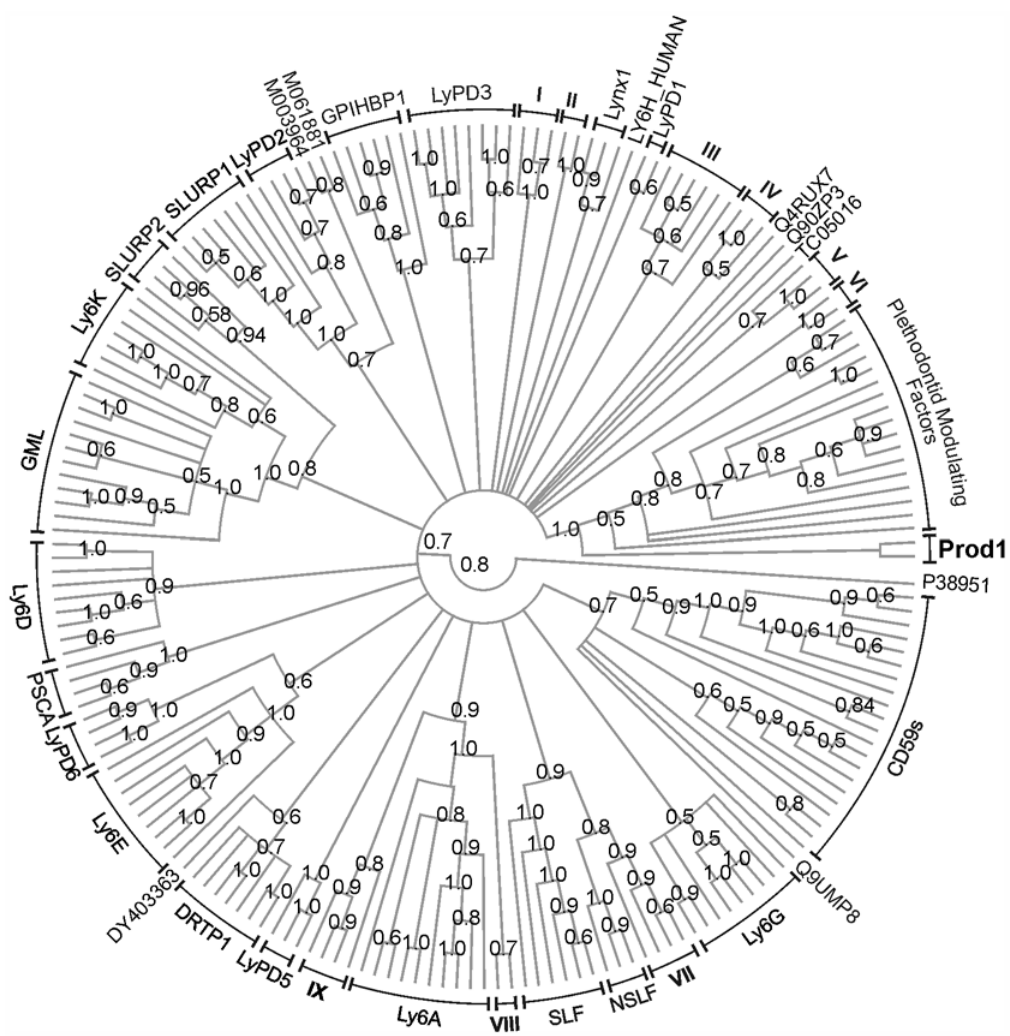
Figure 5. Majority-rule consensus phylogenetic tree of representative sequences of single-domain TFPs computed by Bayesian inference using MrBayes. Numbers indicate the clade credibility (posterior probability) values; only posterior probabilities grater than 0.50 are shown. The sequence of the TFP domain of the Type II activin receptor was used to root the tree, but was removed from the figure. See Table S3 for the identity of the sequences in each